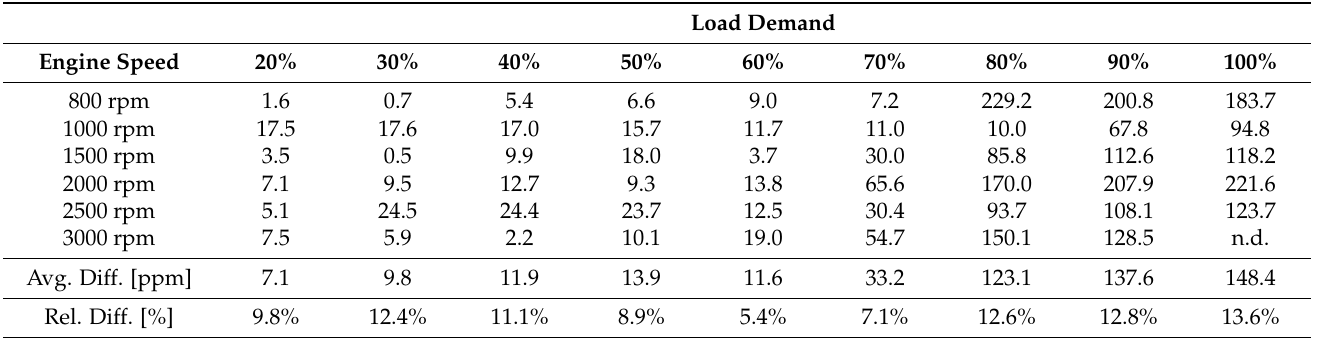
Table 4. Summary of average absolute differences (ppm NO x ) between Tekber and Horiba equipment with EGR. Load Demand